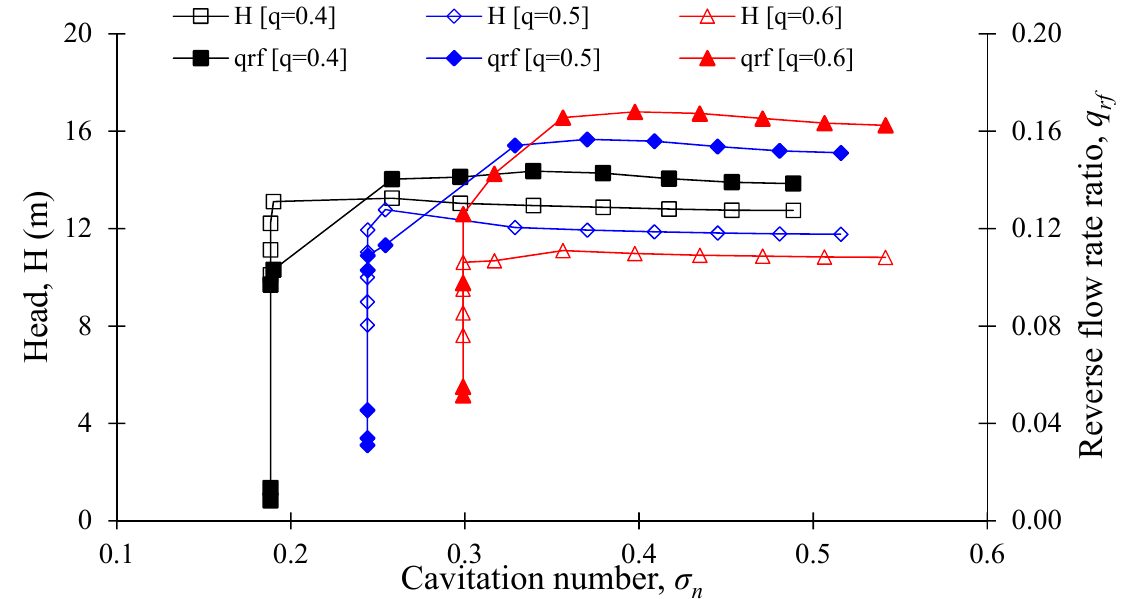
Figure 23. Relationship between suction performance and reverse flow rate in the AJP model with J-Groove.